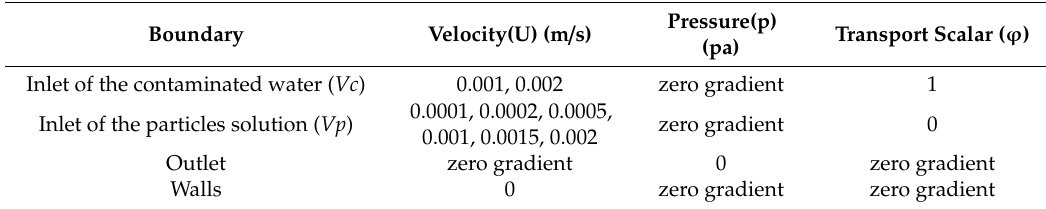
Table 2. Boundary